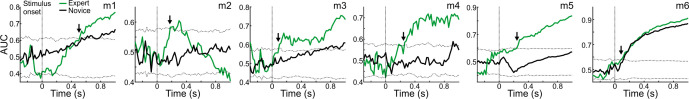
Choice-AUC responses for all mice.Choice AUCs during the trial for all mice during novice (black lines) and expert (green lines; Similar to Figure 3B, right panel). Dashed black lines display the mean ±3 s.t.d of AUC for trial shuffled data. Arrows indicate the latency of the c (i.e. the first time frame exceeding the shuffled data).